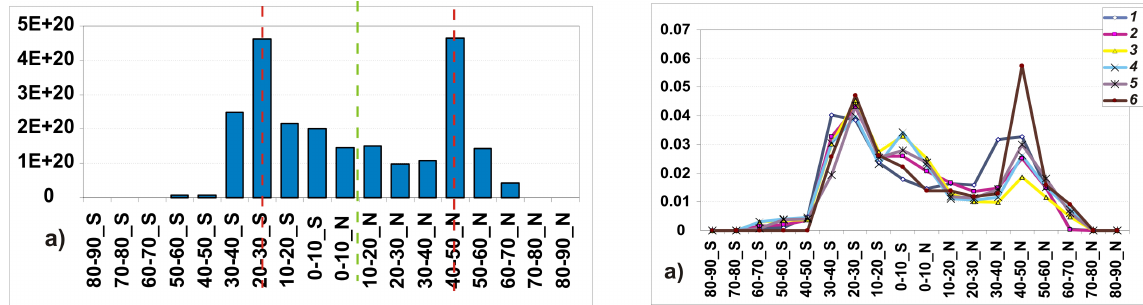
Fig. 1. The distribution of the energy density over latitude (a) ; the latitudinal distributions of the relative seismic event density for 6 magnitude ranges (b) : 1 for 4.0 ≤ M < 4.5, 2 for 4.5 ≤ M < 5.0, 3 for 5.0 ≤ M < 5.5, 4 for 5.5 ≤ M < 6.0, 5 for 6.0 ≤ M < 6.5, 6 for 6.5 ≤ M . The data were adopted from the (ISC UK)